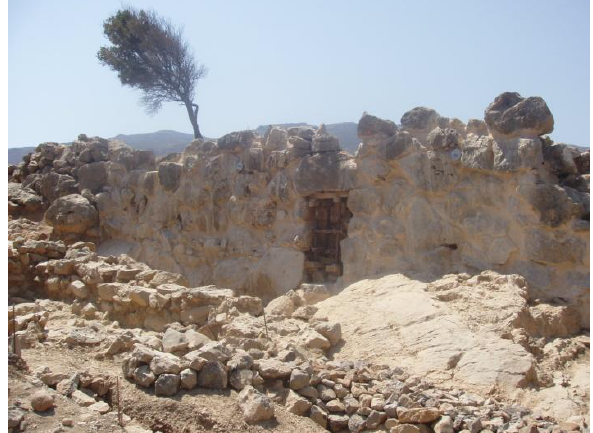
Figure 5. “Guard house” of Choiromandres, East Crete